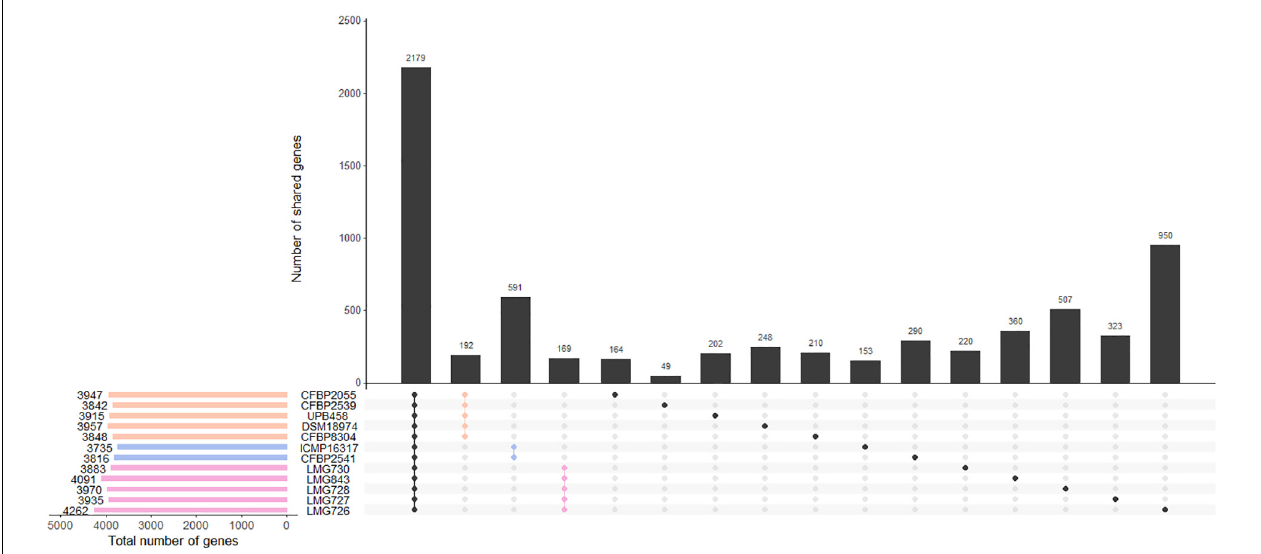
FIGURE 3 | Gene content of the 12 X. translucens pathotype strains used in this study. Vertical bars show the number of genes exclusive to the strains marked in the matrix below. The first group represents the core genome of the species. The second, third, and fourth groups represent genes that are exclusive to the three clades, as indicated by their respective color. Other groups represent genes that are exclusive to one strain. Horizontal bars show the total number of genes in each strain. Orange: clade Xt-I, blue: clade Xt-II, pink: clade Xt-III.